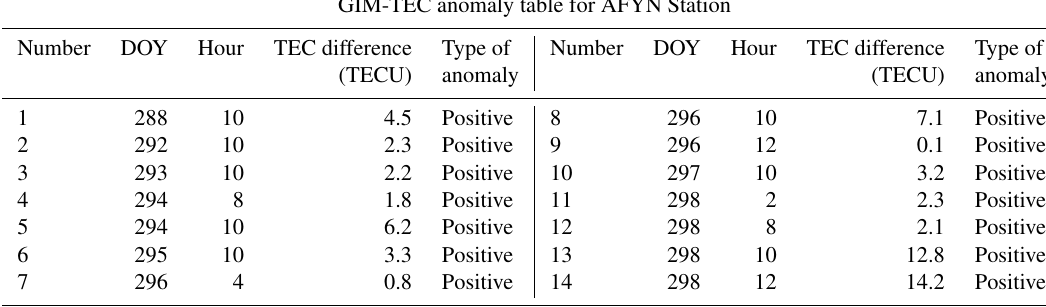
GIM-TEC anomaly table for AFYN